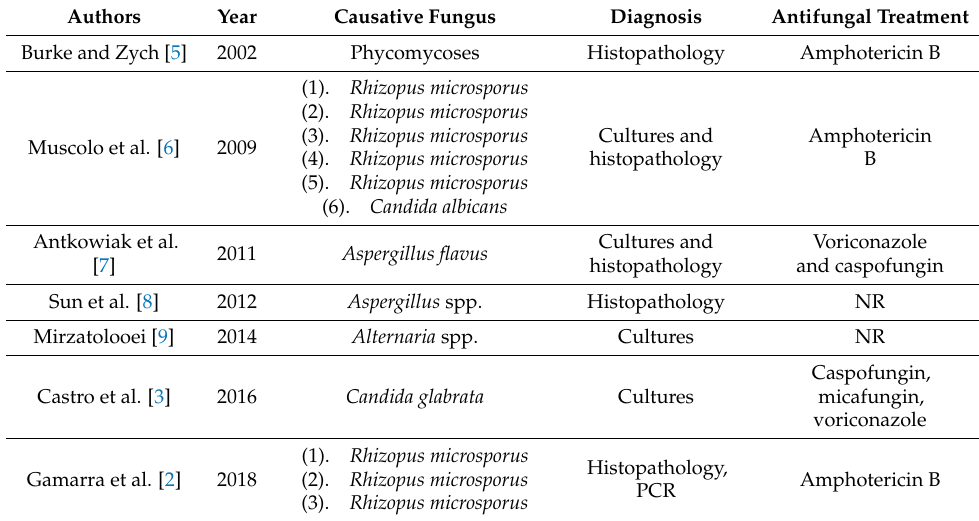
Table 1. Review of all the published cases of fungal septic arthritis following ACLR. The causative fungi, definite diagnosis, as well as antifungal treatment are